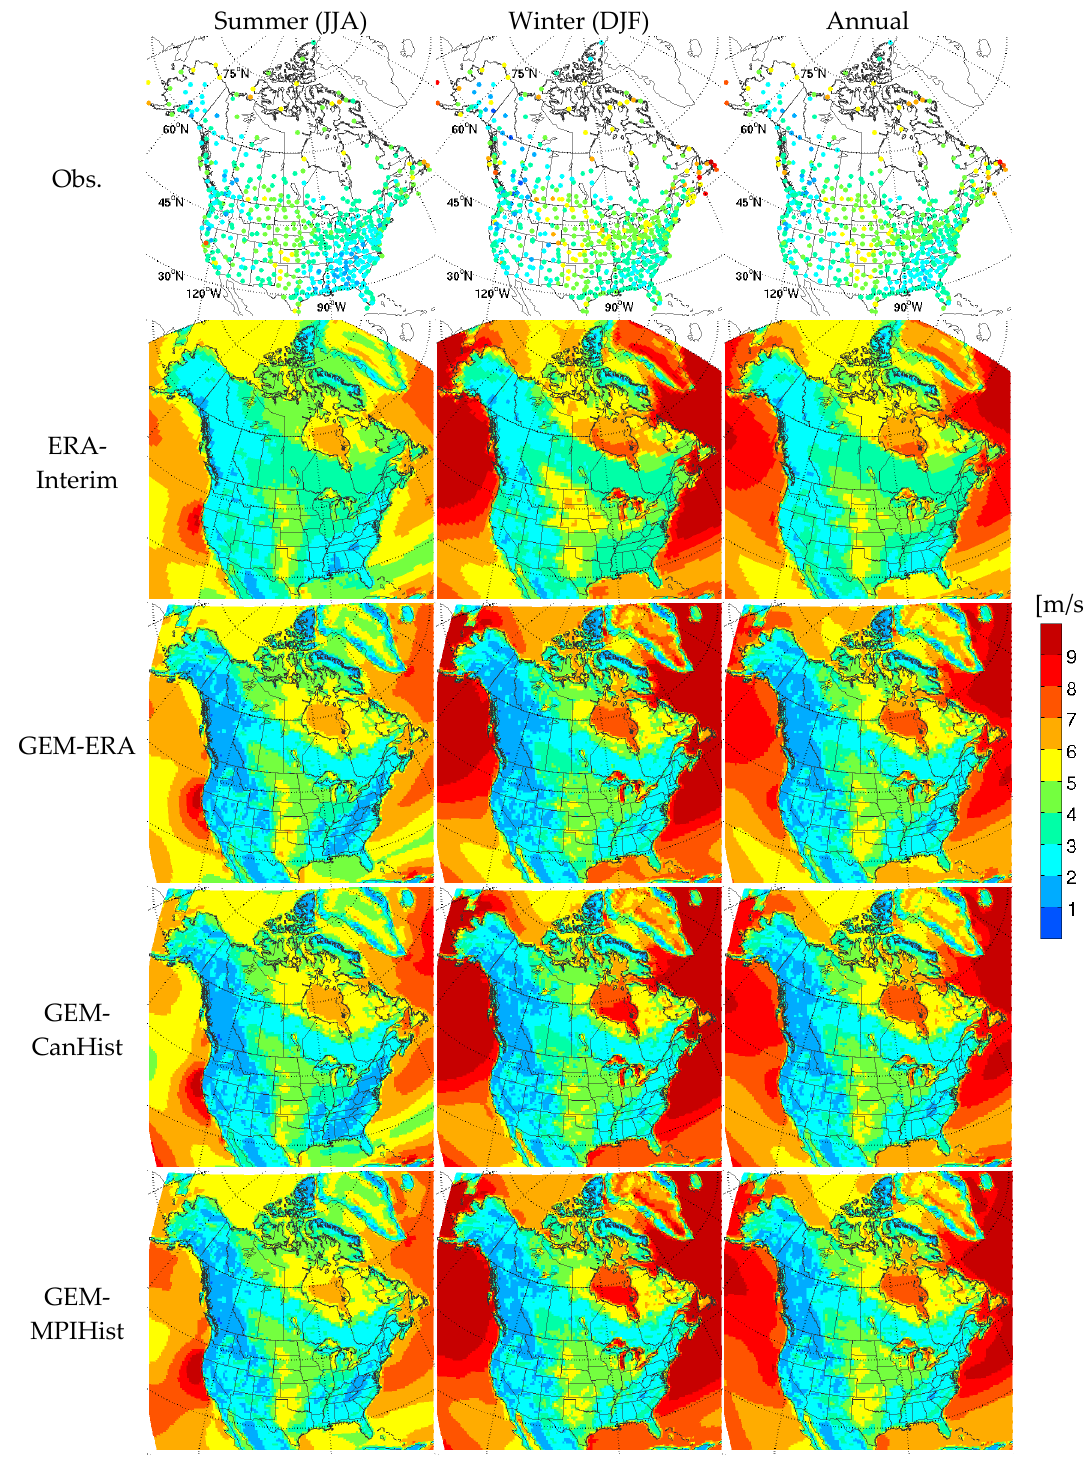
Figure 2. Summer (JJA), winter (DJF), and annual mean wind speed for observations, ERA-Interim, and GEM model simulations (i.e., GEM-ERA, GEM-CanHist, and GEM-MPIHist) for the 1981–2010 period. Observed mean wind speeds are presented using circles, which are color coded following the side bar.